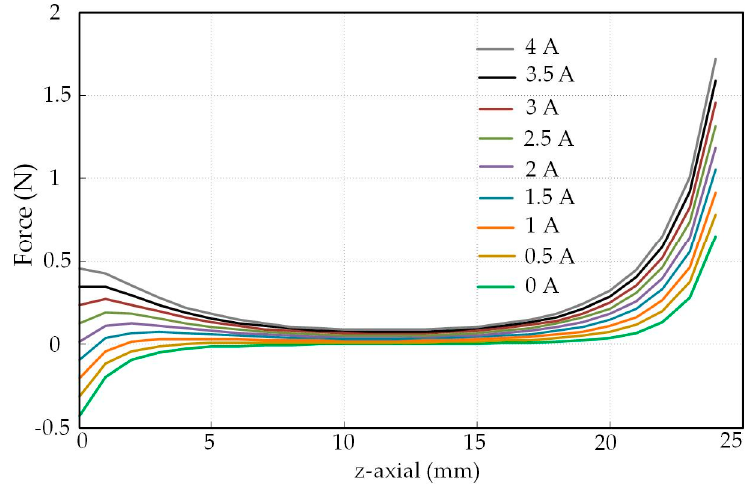
Figure 4. The resultant force acting on the coil under different currents.